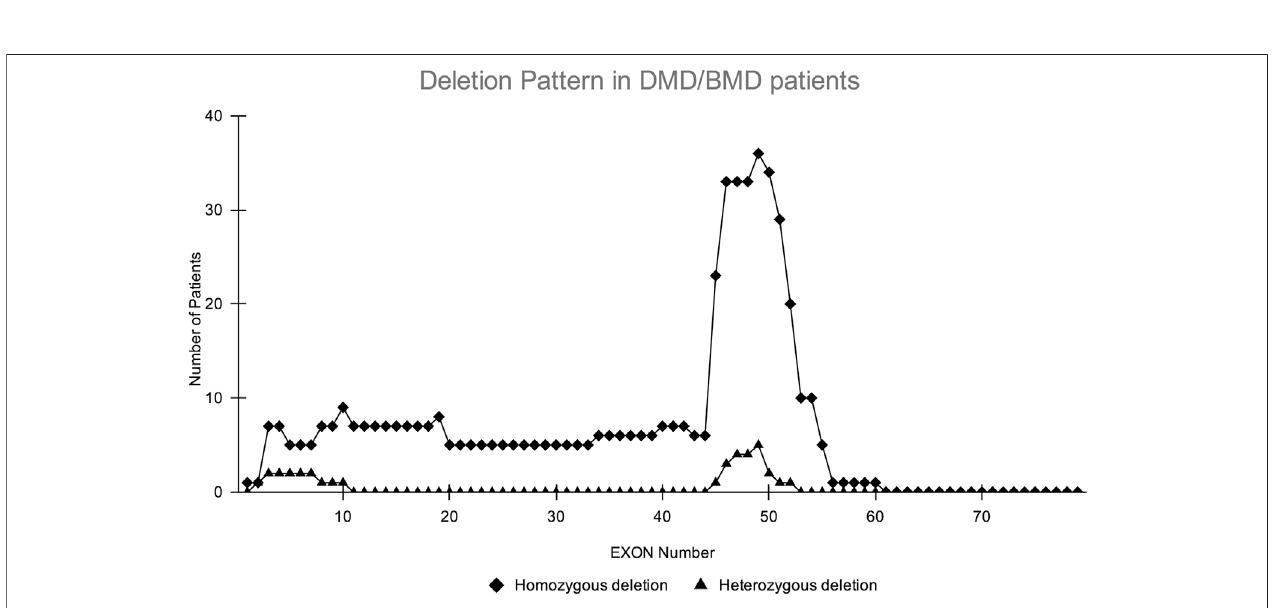
FIGURE2| Homozygousandheterozygousdeletion(femalecarrier)patterninDMD/BMDpatients.The X -axisshowsexonnumberof DMD geneand Y -axisshows the number of patients showing deletion in the study. The highest deletions frequency was found in exons 45 – 52.